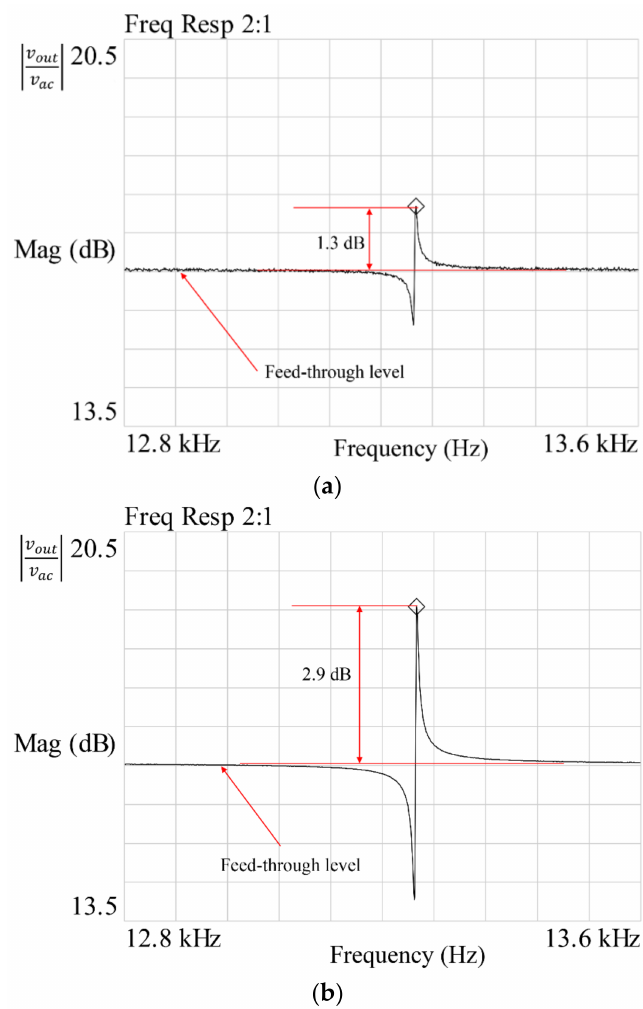
Figure 9. Frequency response function: ( a ) condition 1 and ( b ) condition